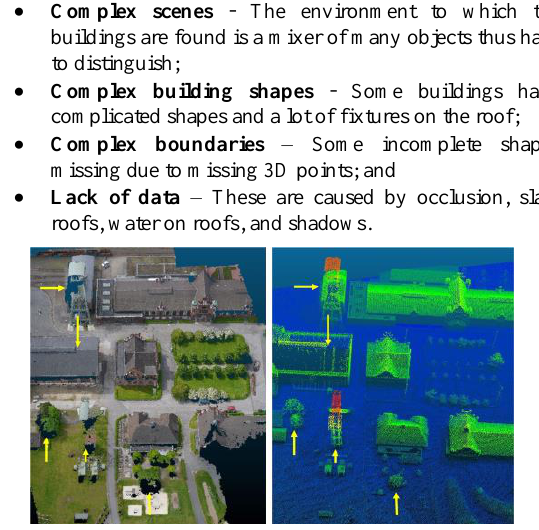
Figure 1. UAV point cloud (left) and ALS point cloud (right) In Figure 1(a), the arrows show scene features void of points due to occlusion and shadow; comparably, in 1(b), the same features are either fully captured or void of points like the